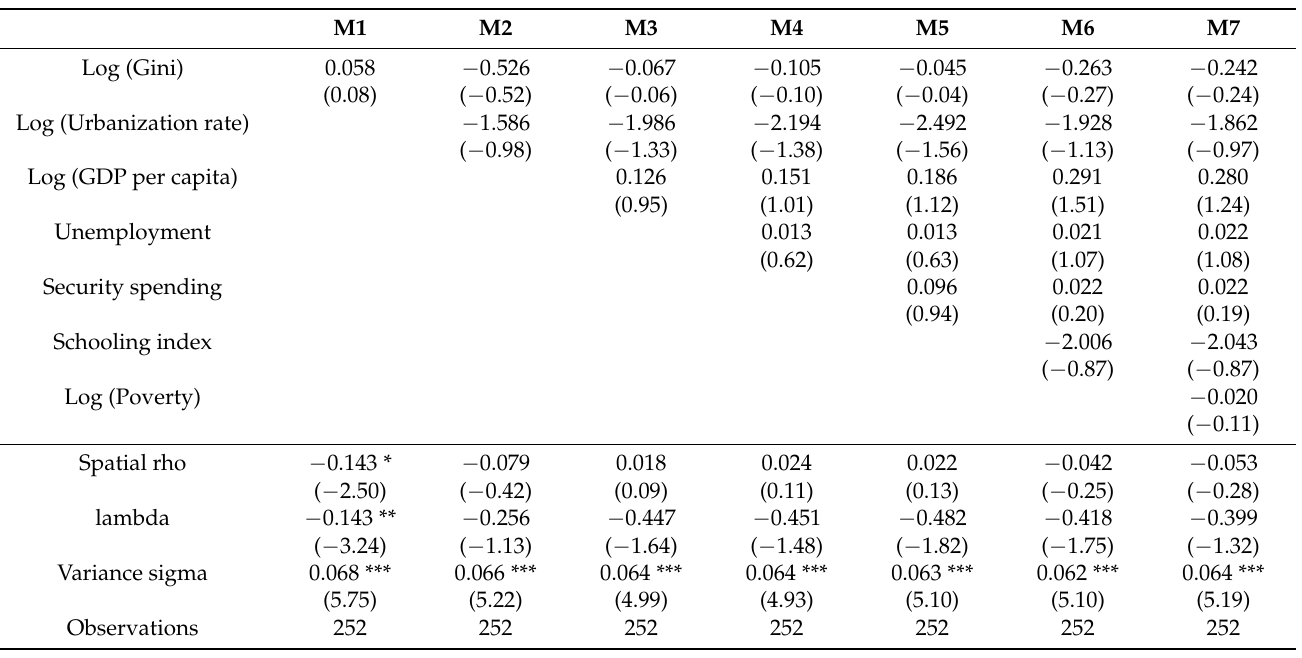
Table 11. Results of the SARMA spatial model, of the relationship between inequality and the homicide rate, including the control